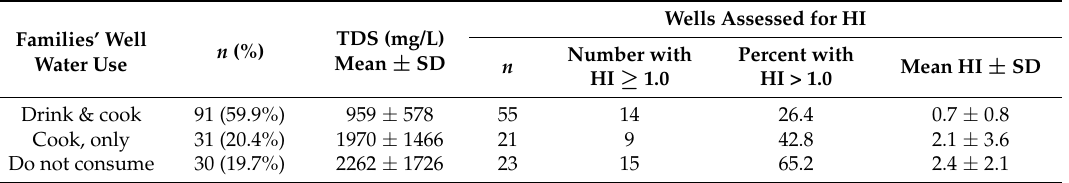
Table 10. Well water consumption, compared to palatability as measured by TDS and to health risk as measured by HI (calculated from Mn, U, As, Zn and NO 3 −